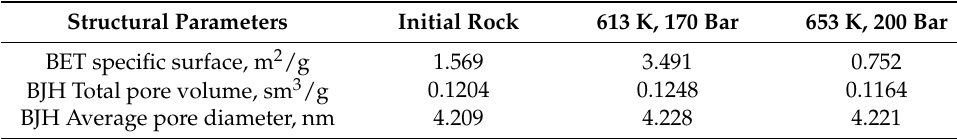
Table 2. The pore space of carbonate